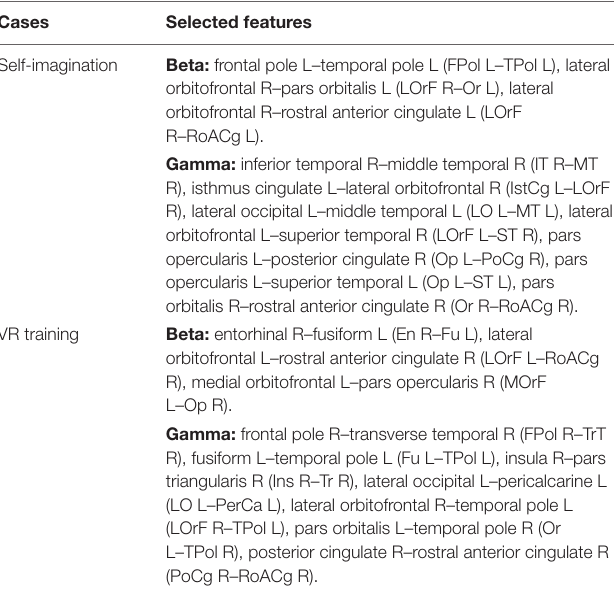
TABLE 6 | Discriminative top 10 functional connectivity